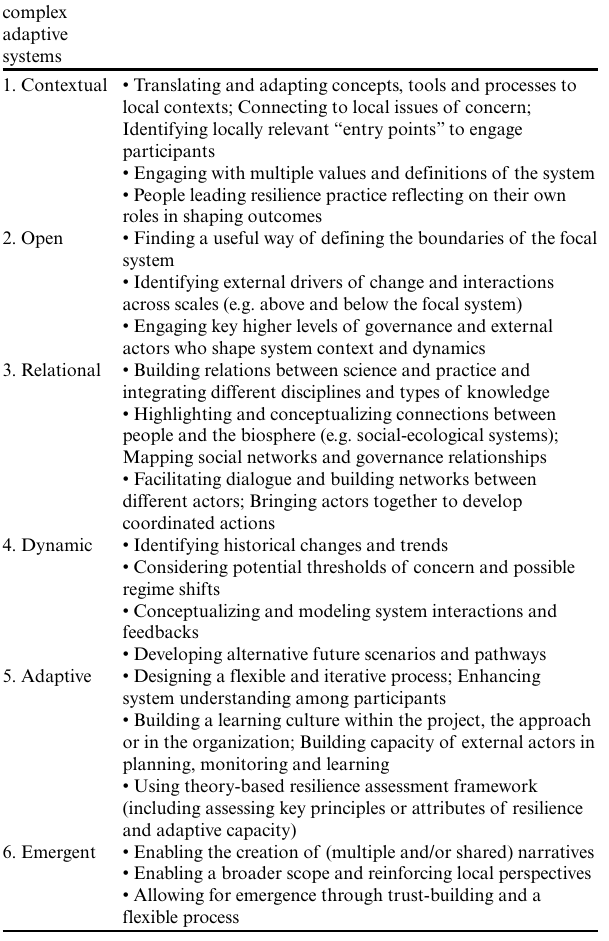
Table 4. Overview of strategies for engaging with complexity. The order of the strategies corresponds to the order they are presented in the